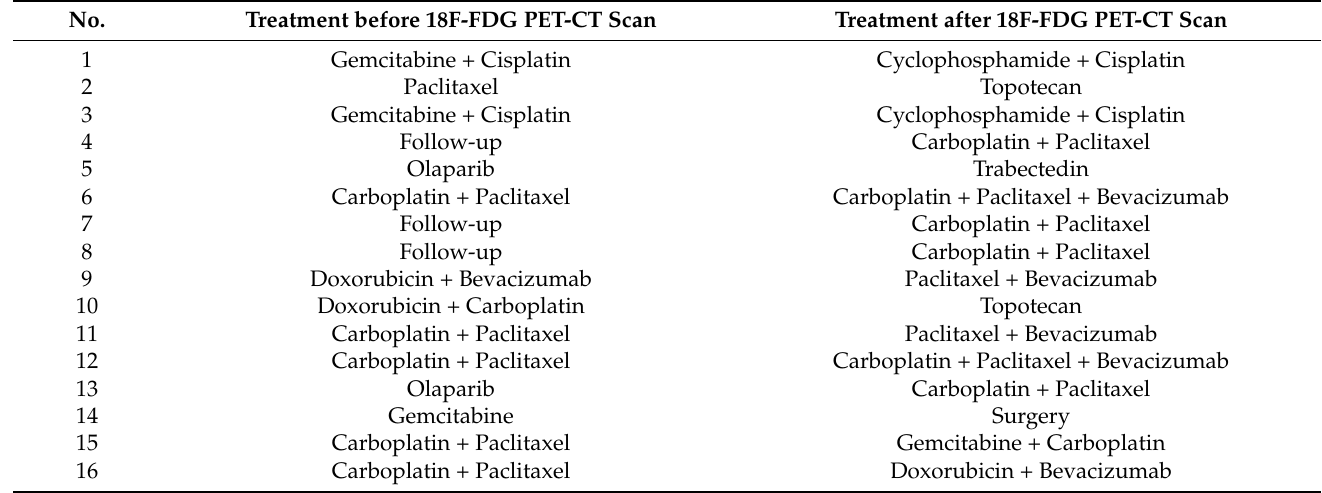
Table 3. A representation of the treatment and patient management strategies being changed after the 18F-FDG PET-CT scan.